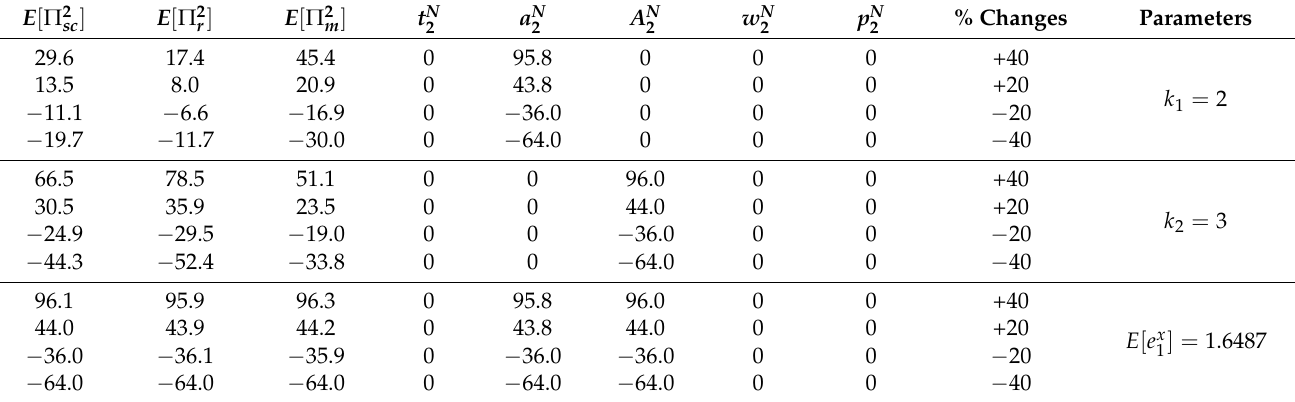
Table 11. The results of the sensitivity analysis with a Nash game for the second